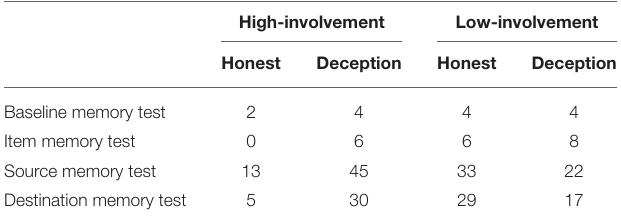
TABLE 3 | The number of non-believed memories in the memory tests for each condition. High-involvement Low-involvement Honest Deception Honest